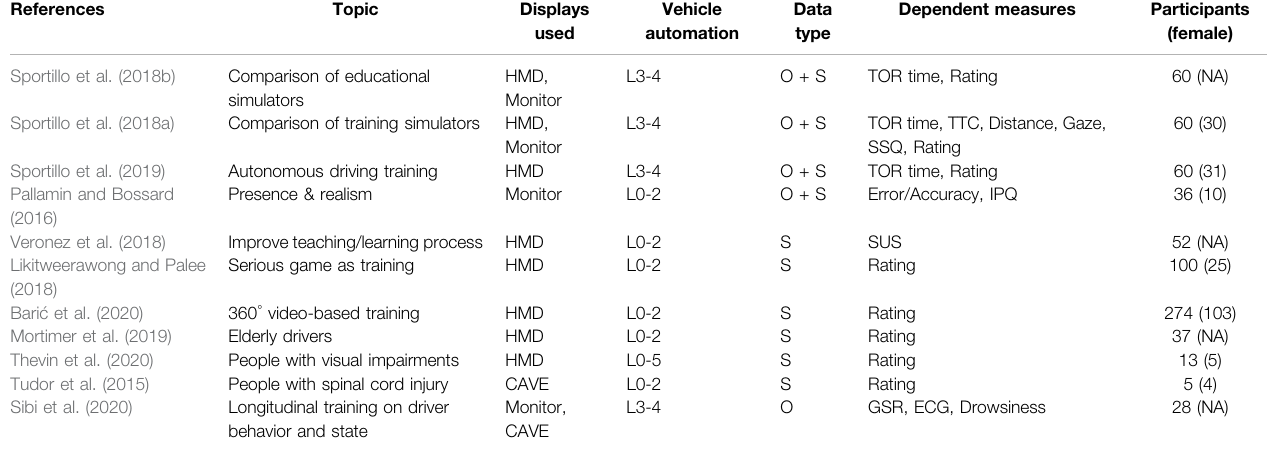
TABLE 6 | Summary of user studies in Driving Education and Training application